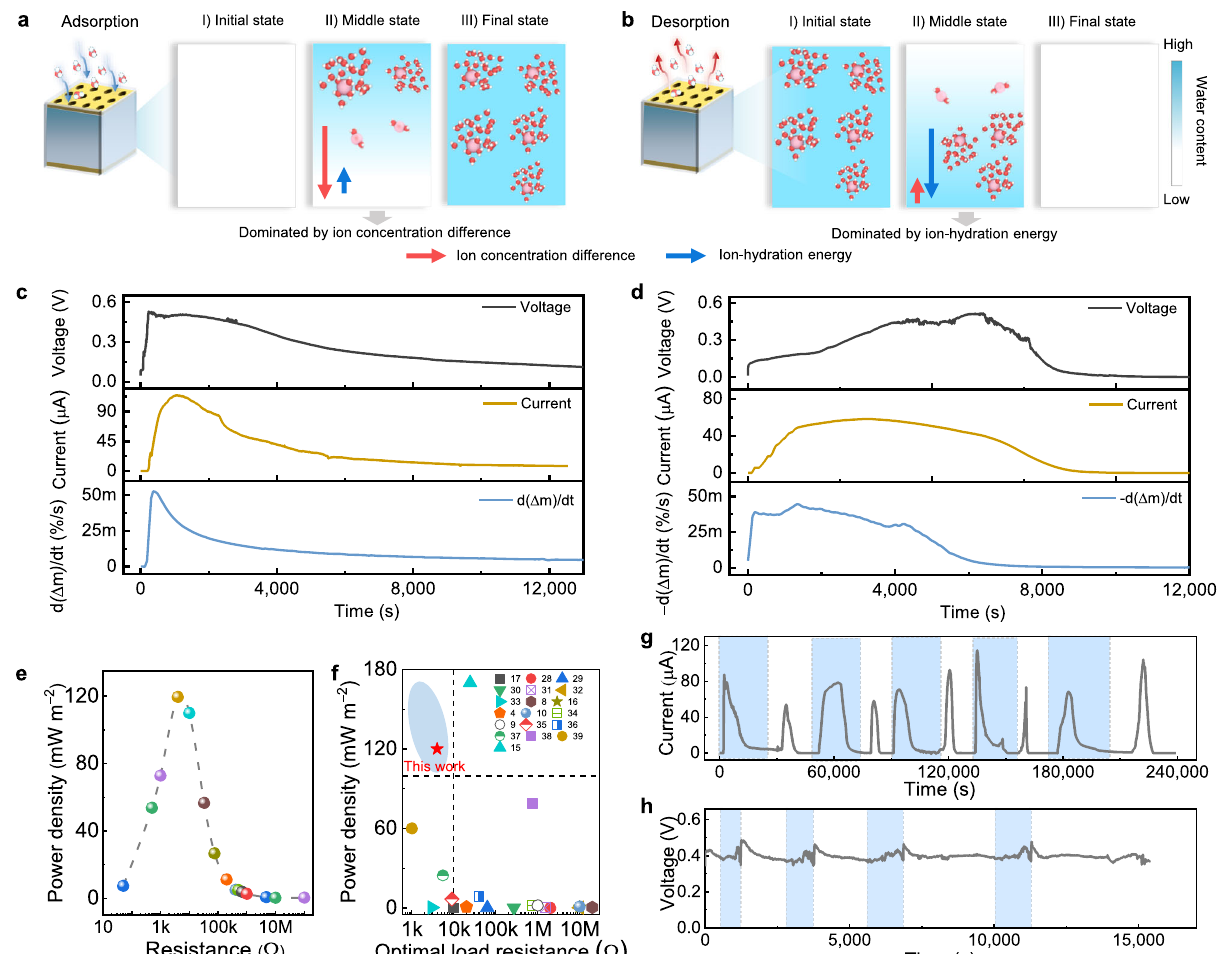
Fig. 3 Electricity generation of a MADG unit. Schematic illustrations of the postulated working principle of a moisture adsorption power generation and b desorption power generation. c Open-circuit voltage, short-circuit current, rate of adsorbing water molecules (d( Δ m )/d t ) during moisture-adsorbing electricity generation under ~100% RH and 40 o C. d Open-circuit voltage, short-circuit current, rate of desorbing water molecules ( − d( Δ m )/d t ) during moisture-desorbing energy generation at ~15 ± 5% RH and 40 o C. e Output power density as a function with varied electric resistances. f Comparison of output power density and internal resistance between MADG and reported moisture induced generators. g Cyclic current output of repeatable moisture adsorption and desorption power generation for MADG in a simulated dynamic ambient condition. The blue region represents adsorption process at high RH condition (90 ± 10%, 30 ± 10 o C) and white region denotes desorption process at low RH environment (15 ± 5%, 30 ± 10 o C). The switch point of two processes are selected at fi nial state of adsorption and desorption. h Voltage output of MADG device in response to switchable RH. The switch point is selected at middle state of adsorption and